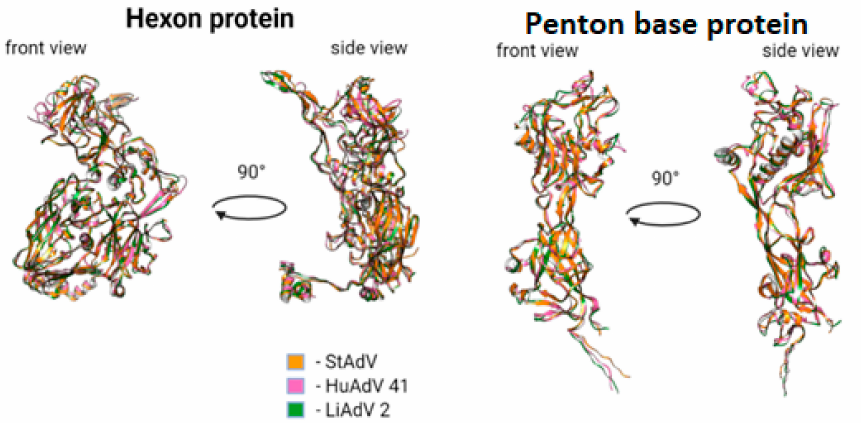
Figure 6. Predicted 3D structure of hexon and penton base proteins, compared to hexon and penton base proteins of HAdV-41 and